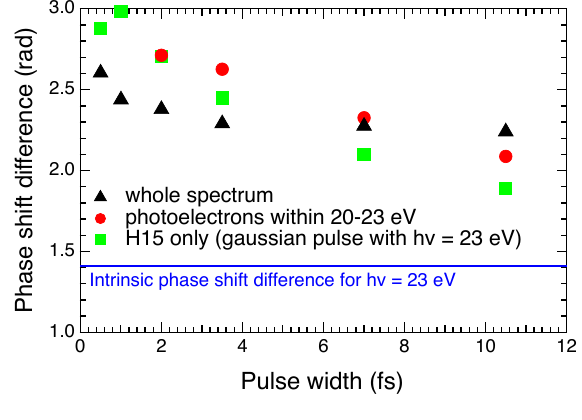
Figure 11. Pulse-width dependence of the phase shift difference δ for high-harmonic pulses composed of multiple harmonic orders (see text). The target atom is helium. Black triangles: derived from the whole 2PI photoelectron wave packets. Red circles: derived from the 2PI photoelectron wave packets within the 20–23 eV energy range. Green squares: for Gaussian pulses with a photon energy of 23 eV. The thin horizontal line denotes the value (1.410 [63]) of the intrinsic scattering phase-shift difference δ for (cid:126) ω = 23 . 0 eV . sc